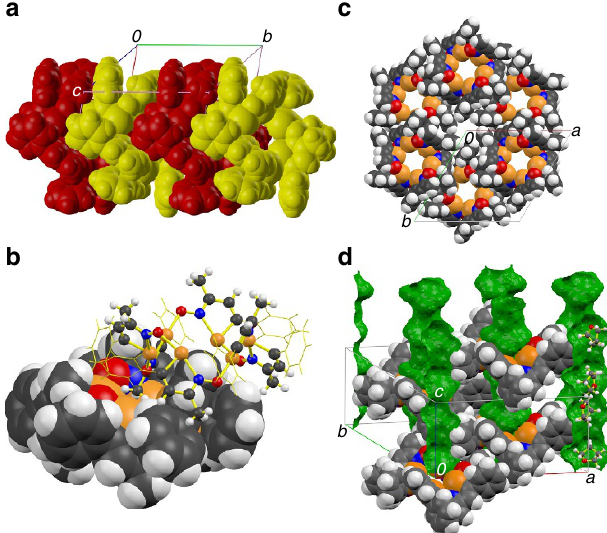
Figure 3 | Detail of the crystalline structures that feature the hexamer 1b 6 . From the crystal of composition 12( 1b ) (cid:3) (CH 2 Cl 2 ): ( a ) stacking of the macrocycles, ( b ) interaction of the methyl group with the cavity of a neighbouring ring. From the crystal of composition 3( 1b ) (cid:3) (C 4 H 8 O): ( c ) packing of a layer in the (0,0,1) plane, ( d ) detail of the crystal structure, highlighting the channels, as well as the location and three orientations of the THF molecules. Panels c and d are simplified for clarity; after ruling out twinning, larger unit cells and less symmetric space groups, the best approximate model features three distinct orientations for the phenyl groups but only one orientation for the C 3 NTe ring. The THF molecules were treated as rigid groups.